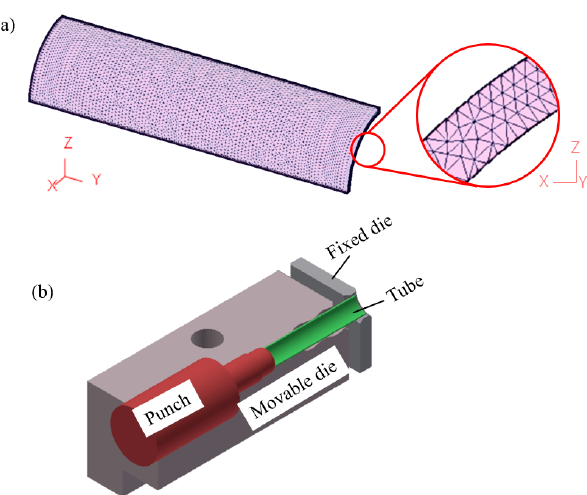
Figure 7. ( a ) Mesh configuration in tube, ( b ) geometric configurations between tube, punch, movable die, and fixed die in FE simulations.